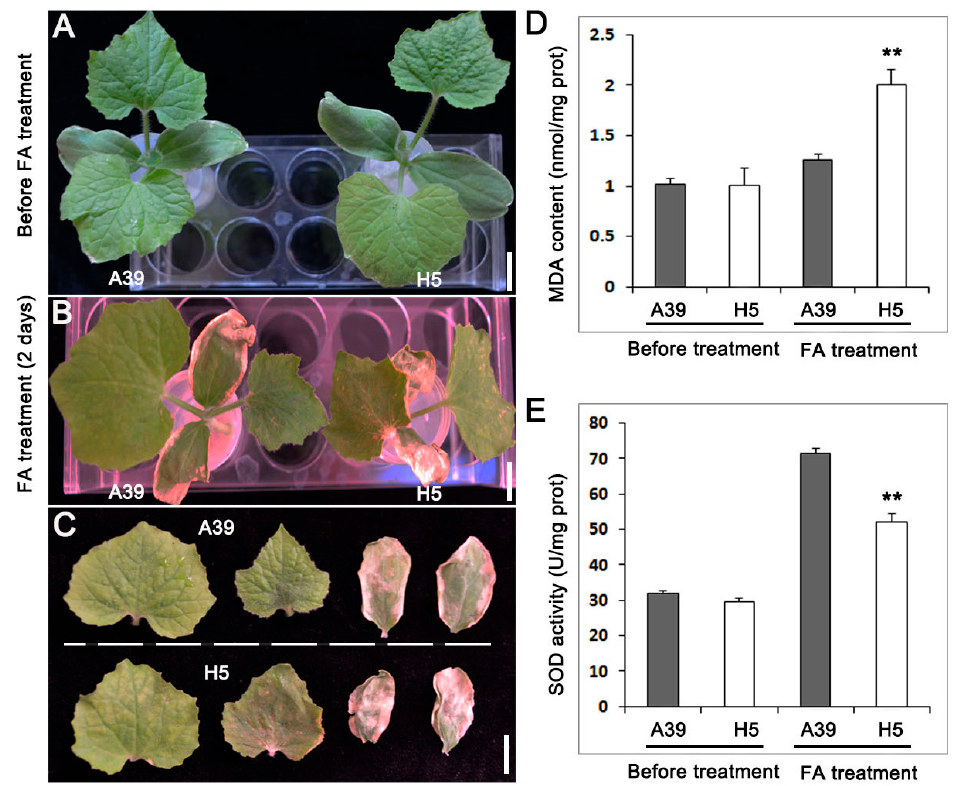
Figure 1. Phenotype observation of ‘A39’ and ‘H5’ under FA stress. ( A ) Seedlings of ‘A39’ and ‘H5’ under normal condition. ( B , C ) Seedlings of ‘A39’ and ‘H5’ at the second day after FA stress. ( D , E ) MDA content and SOD activity before treatment and after 2 days of FA stress. Data is presented as the mean ± standard deviation (n = 9). ** Student’s t -test at p <